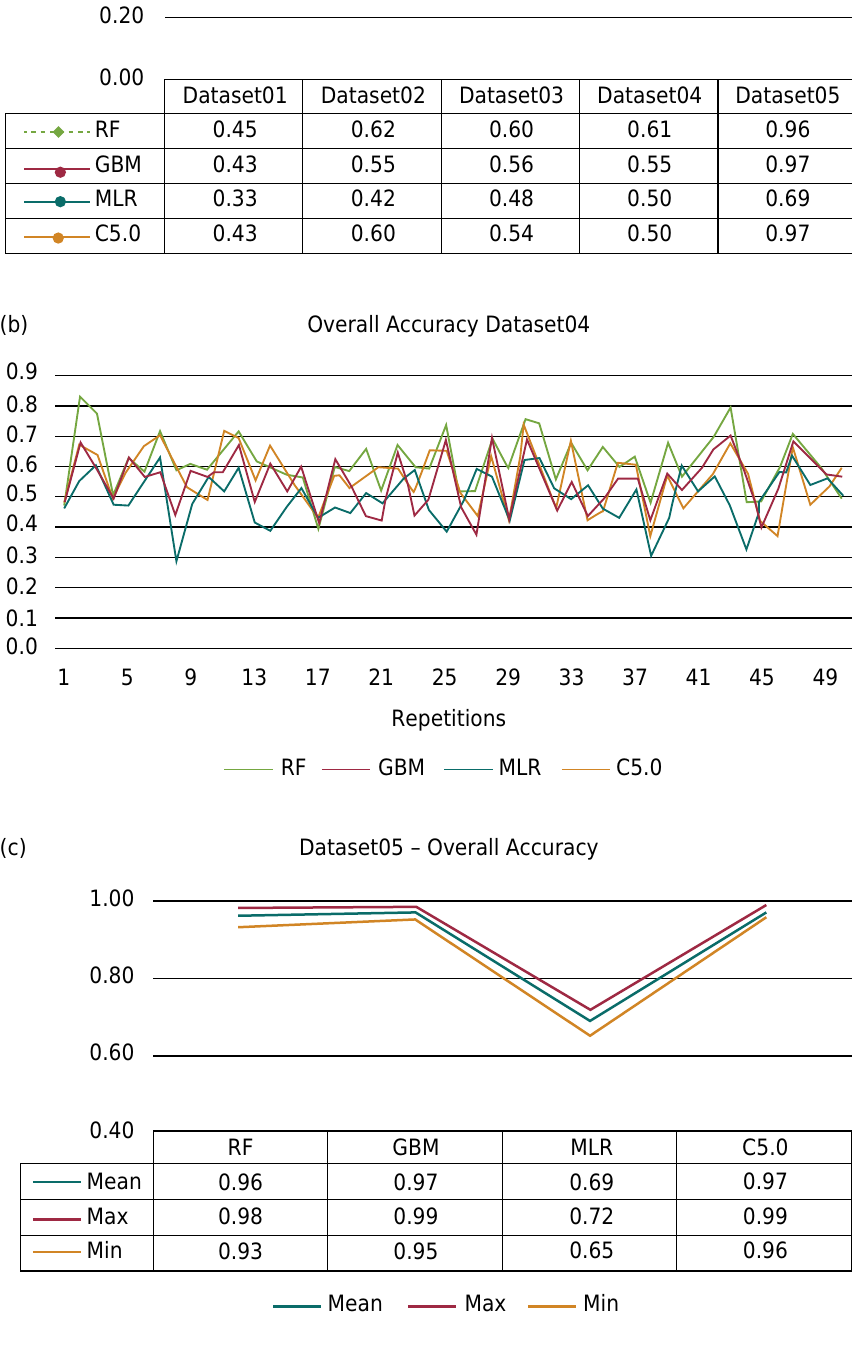
Figure 6. Mean overall accuracy considering four models and five datasets (a); the OA behavior of the random repetitions of the models to Dataset04 (b); and mean, maximum, and minimum OA of the models with Dataset05